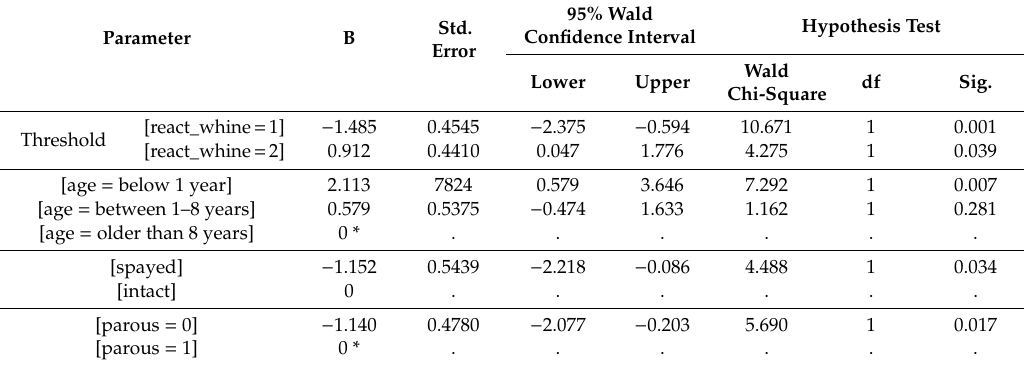
Table 3. Parameter estimates of the reactions of adult female dogs to the whining of the puppies as a function of age, reproductive status, and parousness (had o ff spring or not). GzLM with ordinal logistic. * this parameter is set to 0 because it is redundant. 95% Wald Std. Confidence Parameter B Error